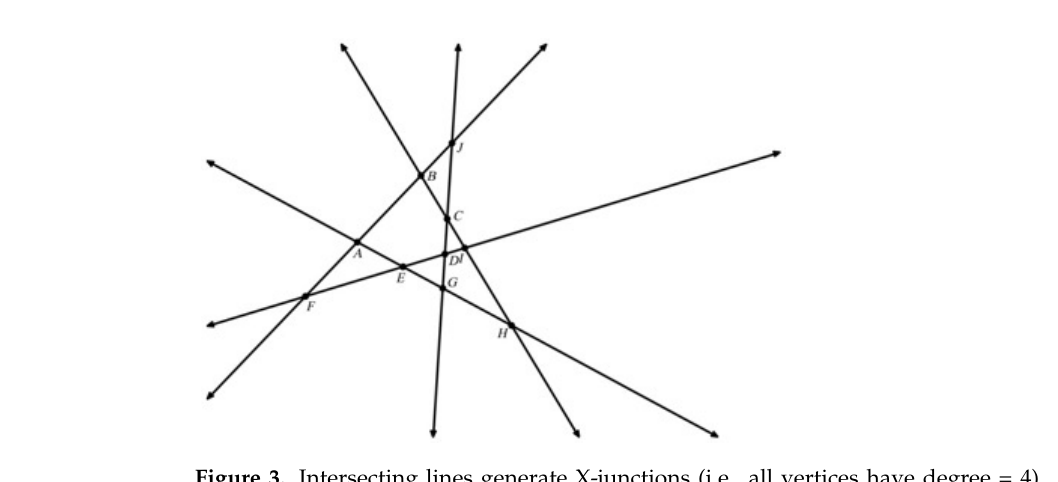
Figure 2: A screenshot of a Voronoi diagram tessellation generated by the software Ka-me which is superimposed on a medial axial transformation of the 3D nanotomography image of a test of a radiolarian generated with the software Amira. The blue lines are the edges of the Voronoi cells, and the light-yellow lines are the edges of Radiolarian test. The forty Voronoi cells lie within the convex hull as the edges of the polygons external to the convex hull extend beyond the rectan- gle containing the image. Only 5-, 6-, and 7-sided convex polygons are observed and notice that all junctions are Y-shaped (i.e., trigonal, vertices with degree = 3) which is illustrative of patterns generated by local, nearest neighbor interactions versus X-junctions produced by global intersecting lines (Figure 3).